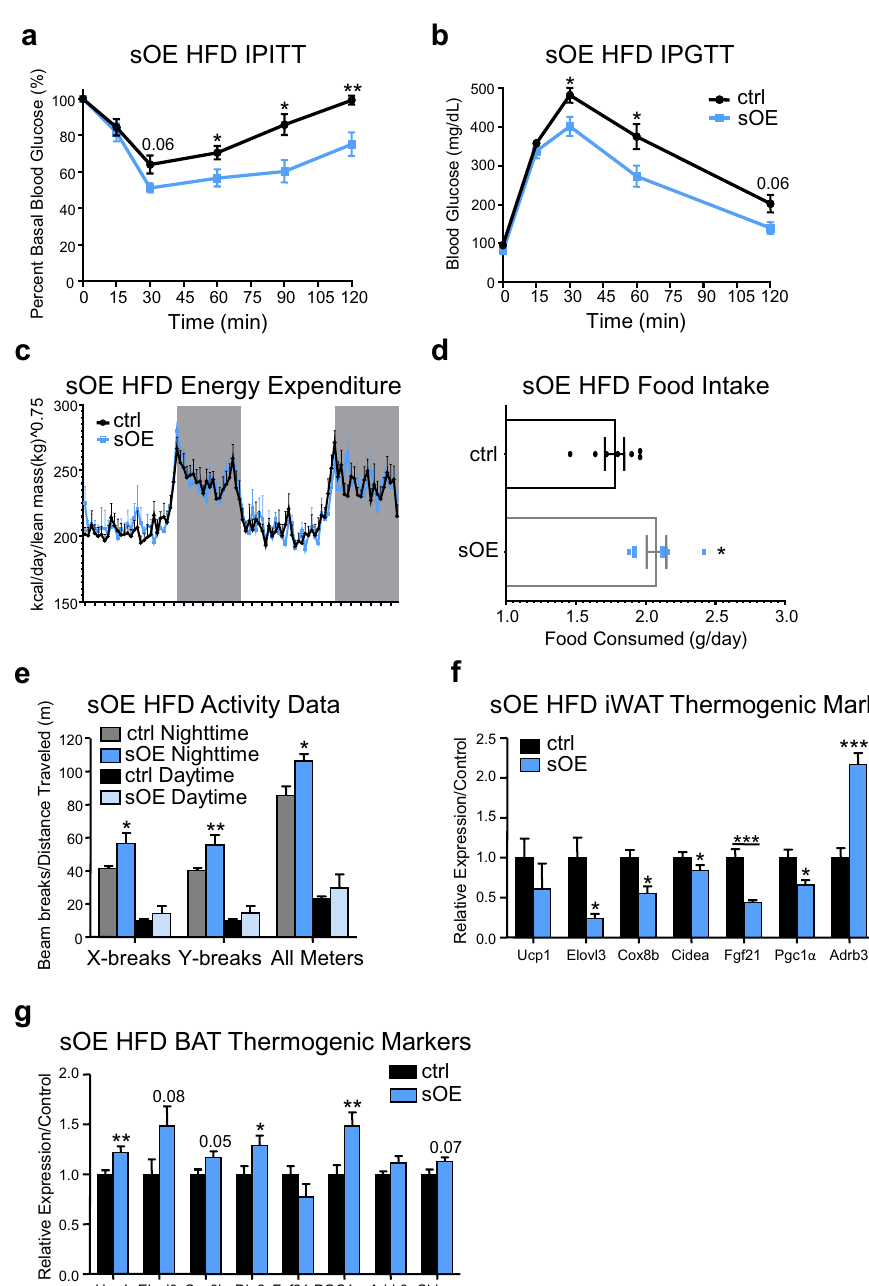
Figure 6. Subcutaneous adipose overexpression of CREB3L3 prevents obesity associated metabolic dysfunction. ( a , b ) Intraperitoneal ( a ) insulin and ( b ) glucose tolerance tests performed with sham control and sOE mice (n = 5–7 mice per group). ( c ) Energy expenditure of sham ctrl and sOE mice fed high-fat diet (n = 6–9 mice per group). Energy expenditure was normalized to the animal’s lean mass. The curve was analyzed using two-way ANOVA. The p value for the column factor (genotype) was 0.4992. ( d ) Average daily consumption of high-fat diet while ctrl and sOE mice were in metabolic cages in metabolic cages (n = 6–8 mice per group). ( e ) Activity measurements of sham ctrl and sOE mice fed a high-fat diet. Data presented as x- and y-axis beam breaks and total movement per day following acclimation period (n = 5–8 mice per group). ( f , g ) Quantitative PCR for markers of thermogenesis in (f) iWAT or (g) brown adipose tissue from ctrl and sOE mice following high-fat diet (n = 6–8 mice per group). Target gene expression was normalized to TBP and presented as fold change over control. Data presented as mean ± SEM with sample sizes listed above. The difference in means was analyzed using Student’s t-test where *P < 0.05, **P < 0.01, ***P < 0.001, and ****P <